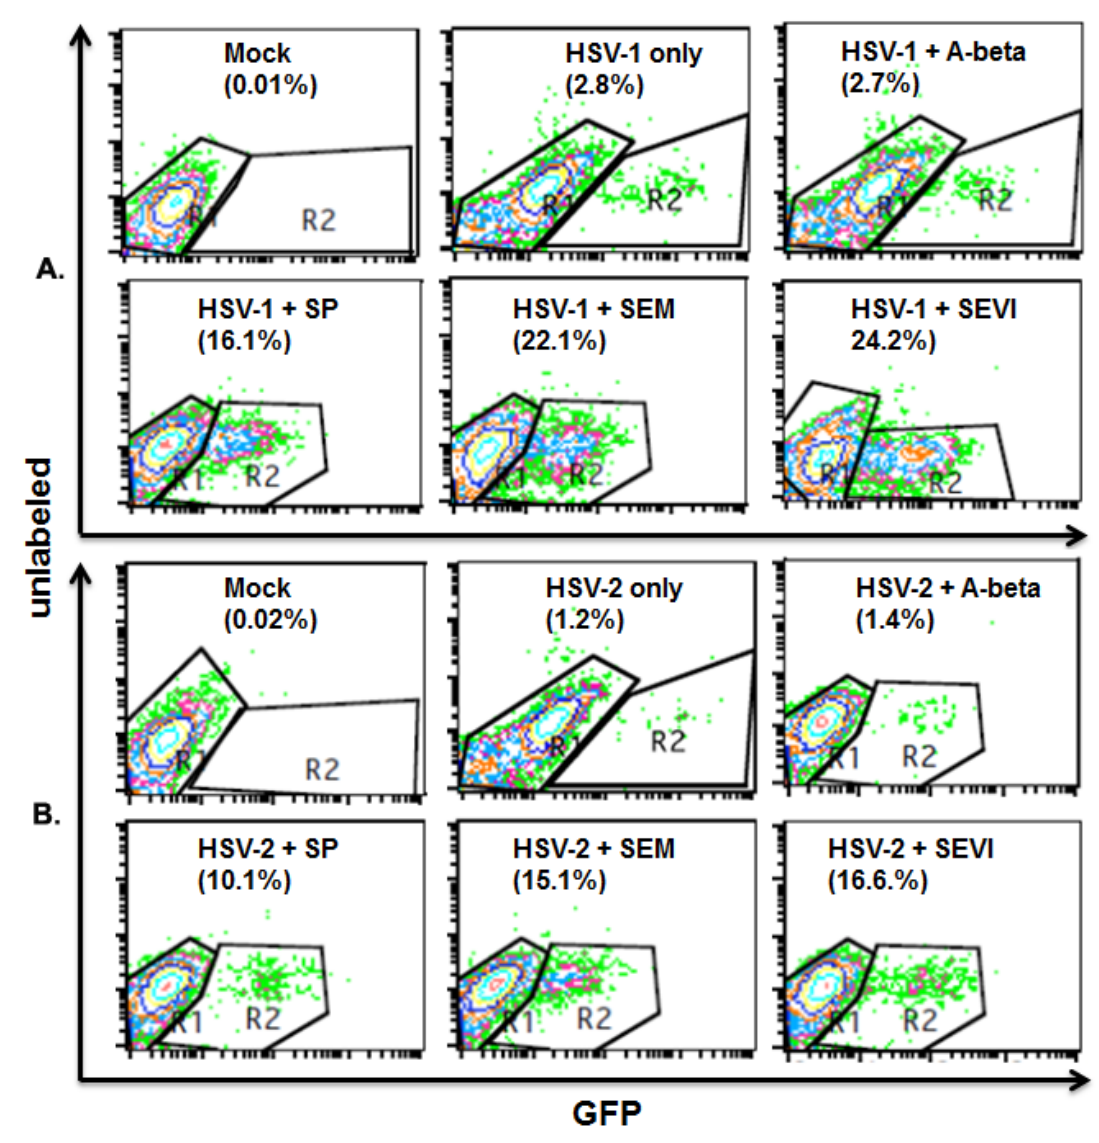
Figure 3. Flow cytometry to detect viral infection rate. ( A ) HSV-1 infection (1 mL per well) in HEK 293T cells. HEK 293T cells were cultured in a 6-well plate. When the cells were 80% confluent, the cells were mock-infected or infected with HSV-1 at an MOI of 0.1. Virus was pre-incubated with 10  μg/mL of A-beta, SEM amyloids, SEVI, or SP (1:1000 dilution) for 1 h at 37 °C before infection. The cells were fixed at 8 h post-infection, stained with anti-gD conjugated with FITC, and measured by flow cytometry to detect the percentage of FITC-positive (infected) cells. The percentage of infected cells is shown in the lower right-hand corner; ( B ) HSV-2 infection in HEK 293T cells. The same experiments as described in A, but using HSV-2 instead of HSV-1. Mock-infected cells in the absence or presence of 10 μg/mL of SEM or 10 μg/mL of SEVI were used to control for autofluorescence. Results are representative of one of three